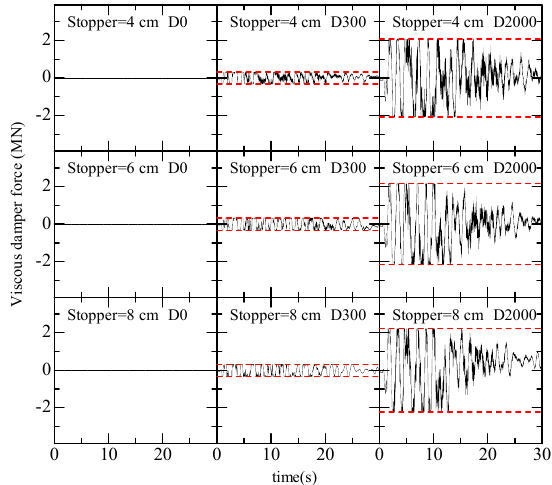
Figure 12. Viscous damper force time history.